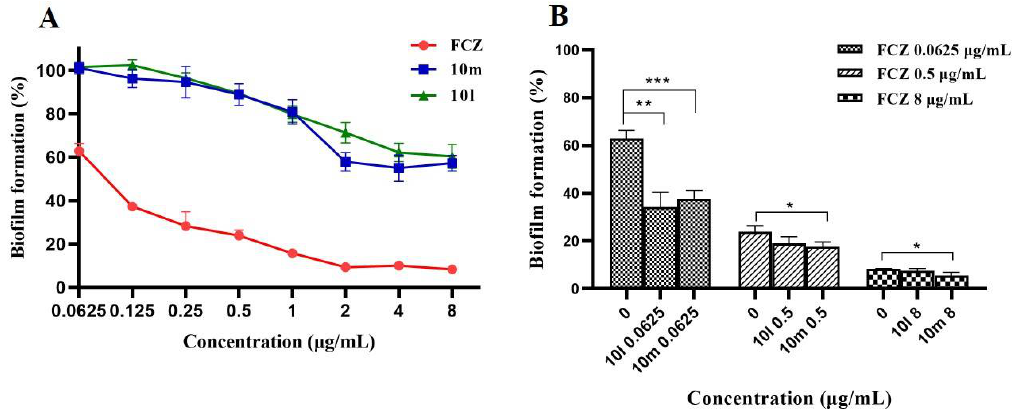
Figure 3. ( A ) Inhibition of biofilm formation in C. albicans with the treatment of FCZ, 10l or 10m alone at the indicated concentrations. ( B ) Inhibition of biofilm formation in C. albicans treated with FCZ in combination with 10l or 10m . * p < 0.05, ** p < 0.01, *** p < 0.001 compared to the corresponding FCZ-treated alone group.